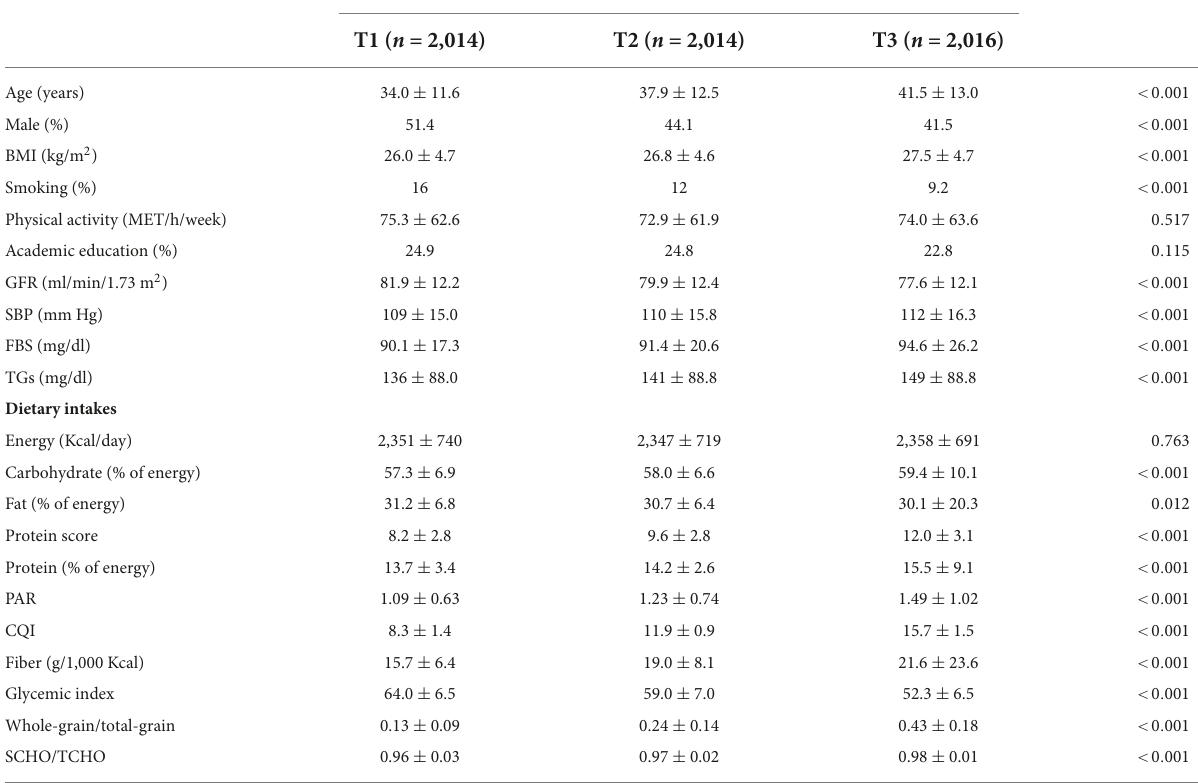
TABLE 2 Baseline characteristics of participants according to tertiles (T) of carbohydrates quality index.